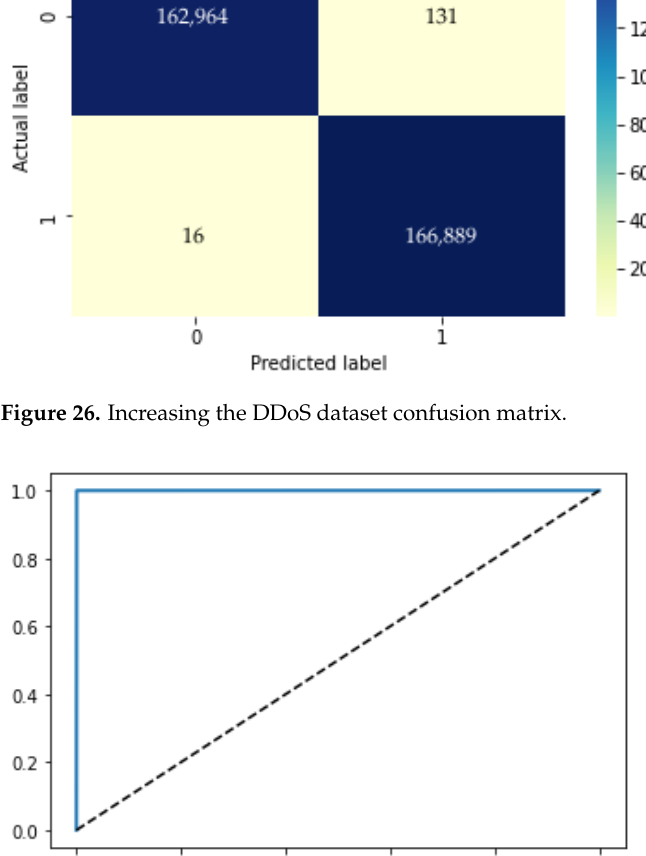
Table 13. Performance metrics for generalization capability of changing DDoS dataset.